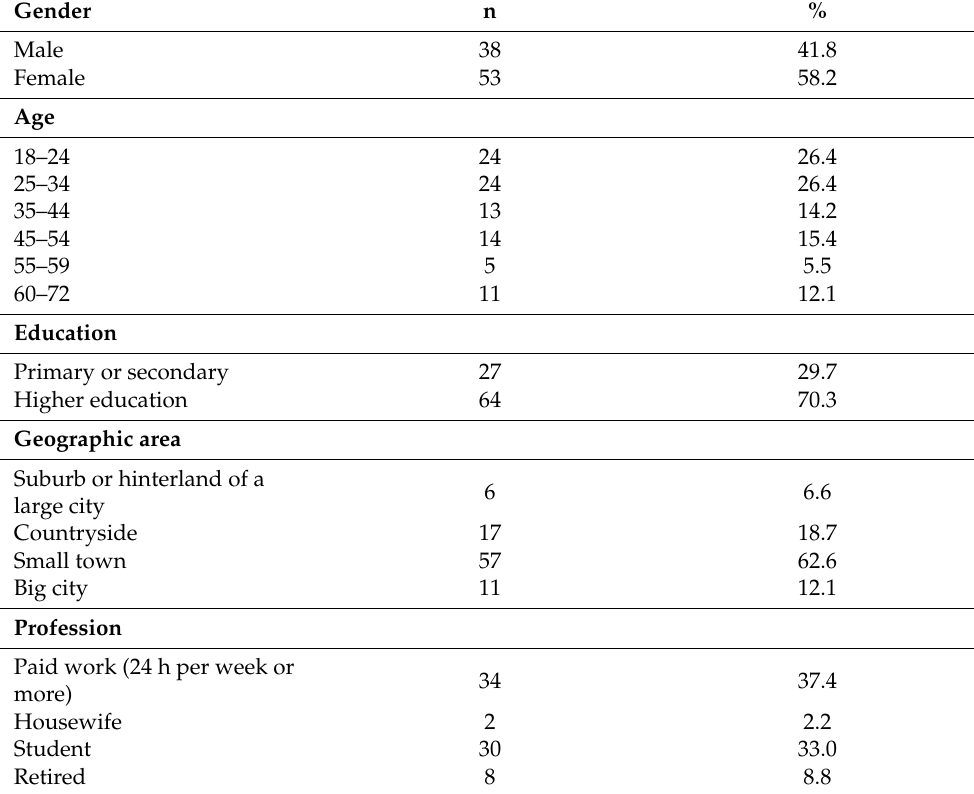
Table 1. Demographic profiles of the sample of participants (n = 91).